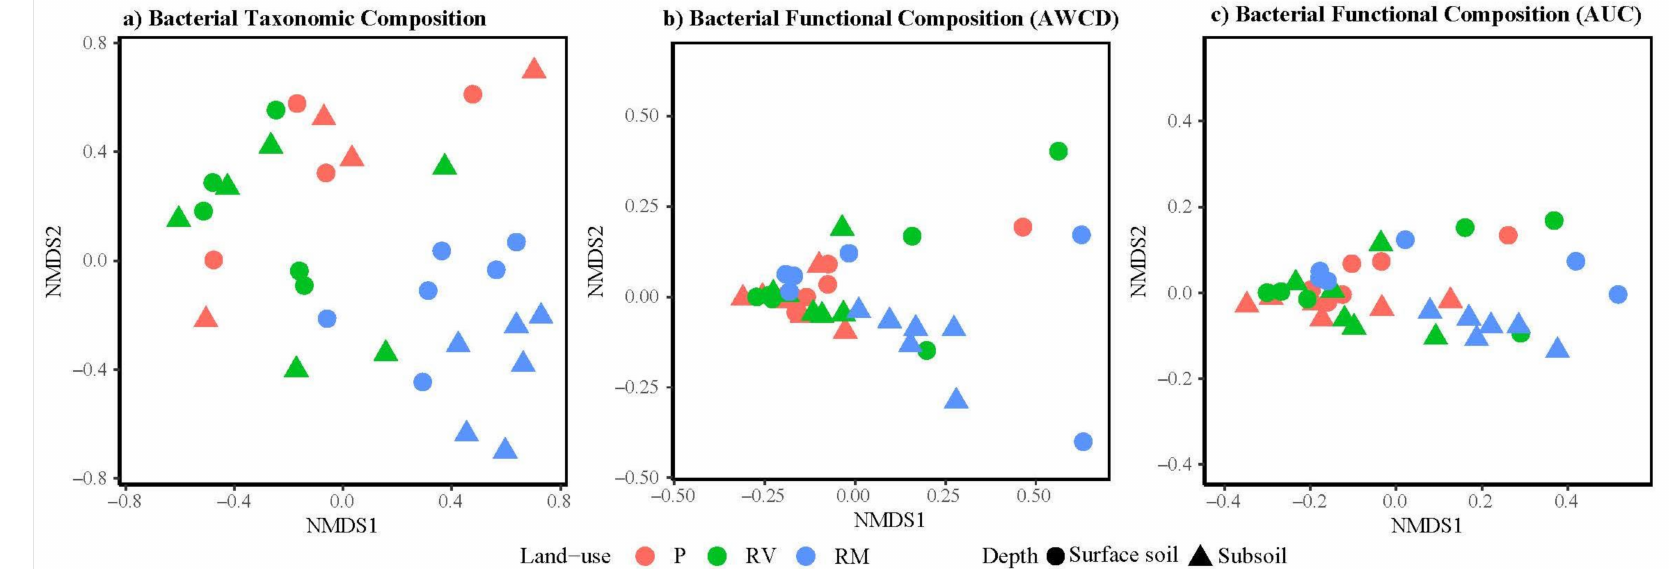
Figure 3. Non-metric multidimensional scaling (NMDS) ordination of ( a ) bacterial taxonomic composition (stress 0.15, non-metric R 2 0.87); ( b ) bacterial functional composition (community-level physiological profiling (CLPP)—represented as average well color development (AWCD), stress 0.07, linear fit R 2 0.99); and ( c ) bacterial functional composition (CLPP—represented as area under the curve (AUC), stress 0.04, linear fit R 2 0.99). Points are colored based on land use (red = pasture (P), green = revegetated (RV), and blue = remnant (RM)) with symbols distinguishing soil depth (circle = surface soil and triangle =